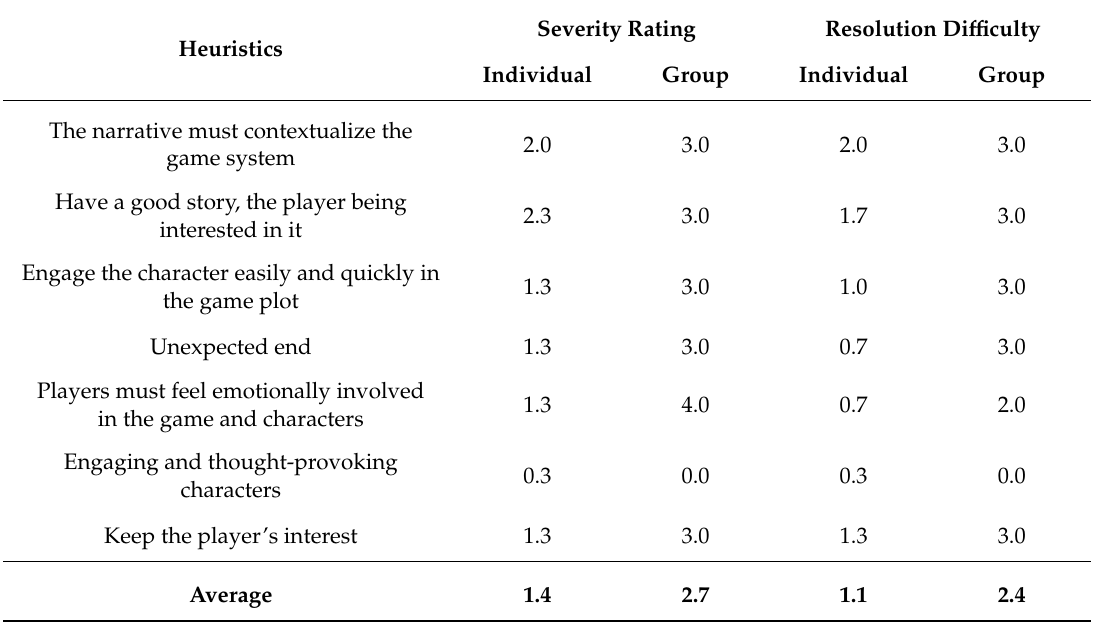
Table 5. Heuristics analysis of the game’s narrative [38].